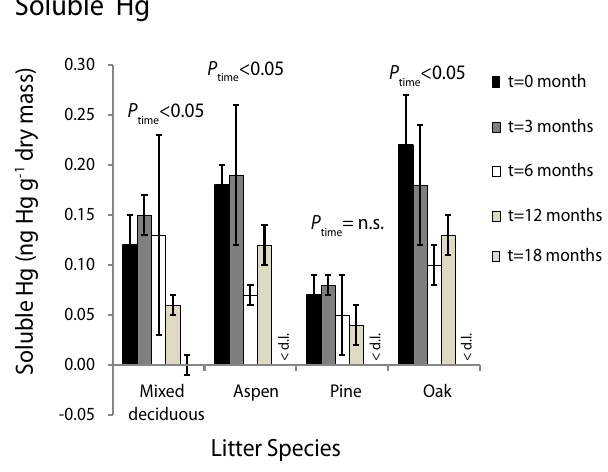
Fig. 4. Development of soluble Hg per unit dry mass throughout the 18 months of litter decomposition in the controlled laboratory study. Bars represent means ± standard deviations of five replicate samples. P -values are effects of Time for individual species based on Bonferroni post-hoc analyses (Table 2). < d.l. refers to values below the limit of